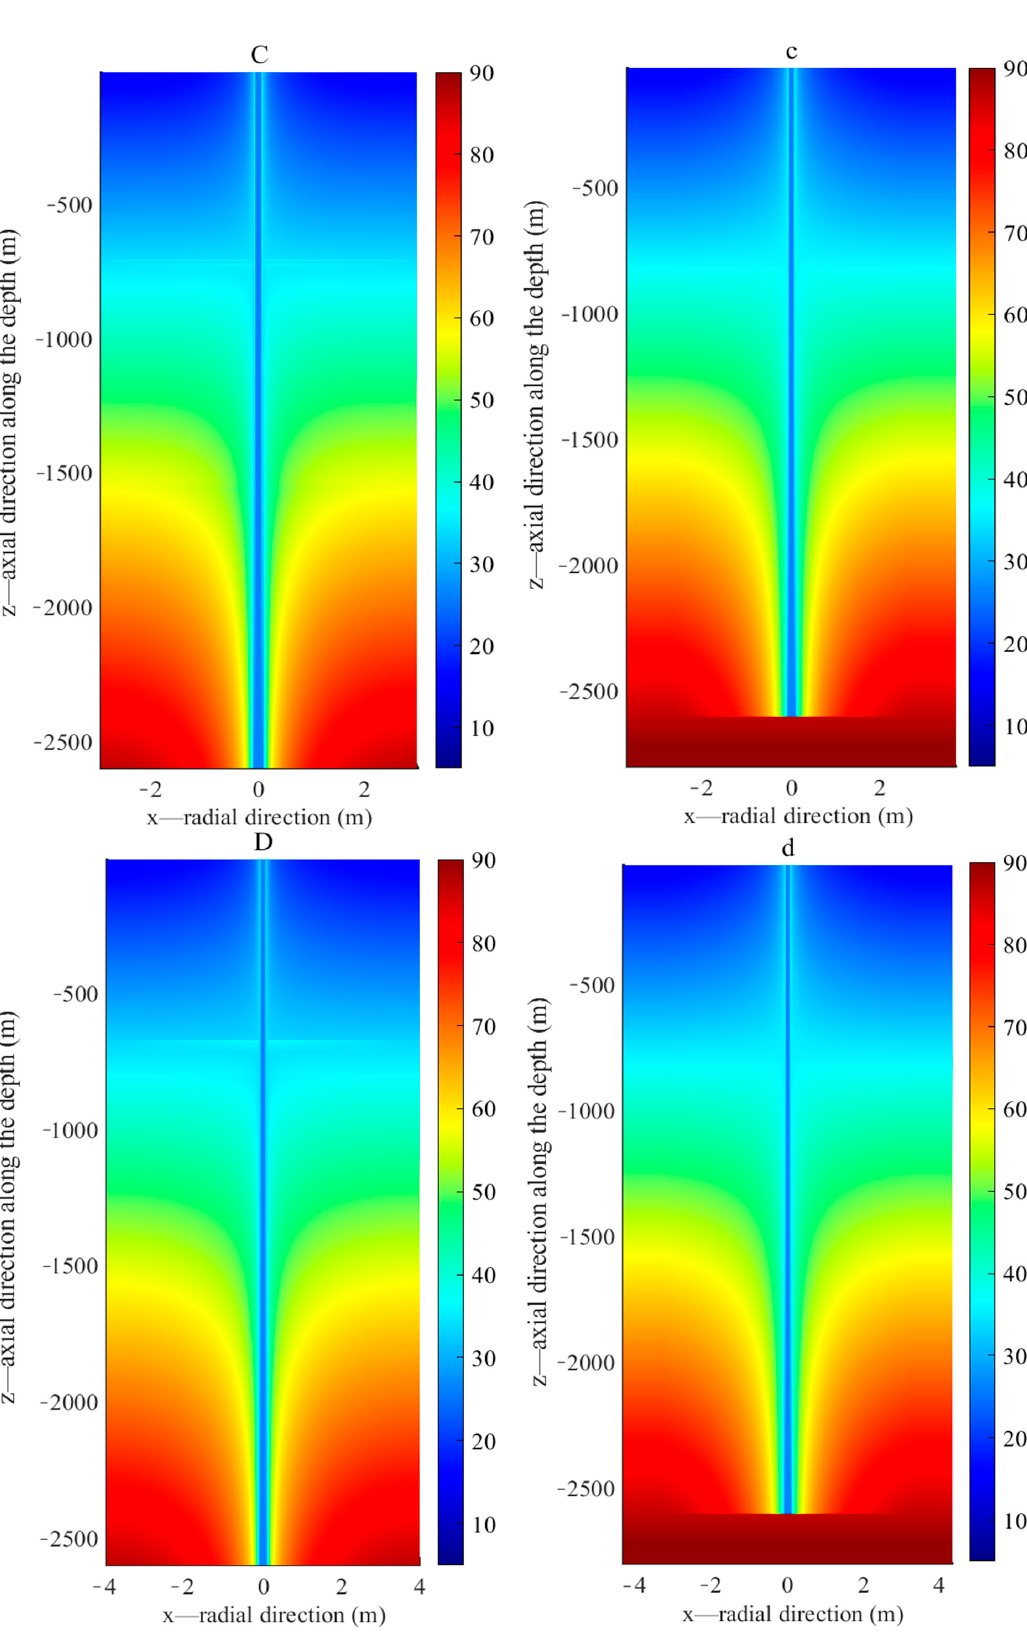
Figure 12. Rock temperature distribution underground during the low temperature heat storage days (( A – D ) depict the simulation results at 1 day, 10 day, 20 day, 30 day respectively from the proposed model; ( a – d ) show the corresponding results from the OGS